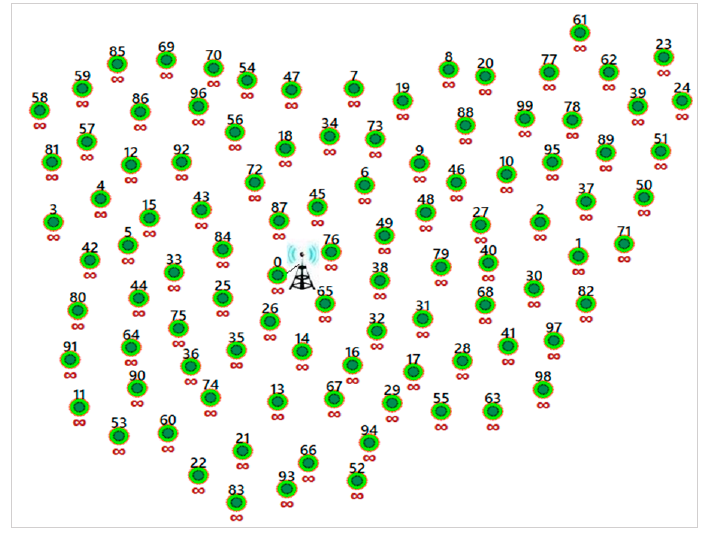
Figure 1. Static wireless sensor network (WSN) with 99 homogeneous sensors and the centralized sink node (node 0).